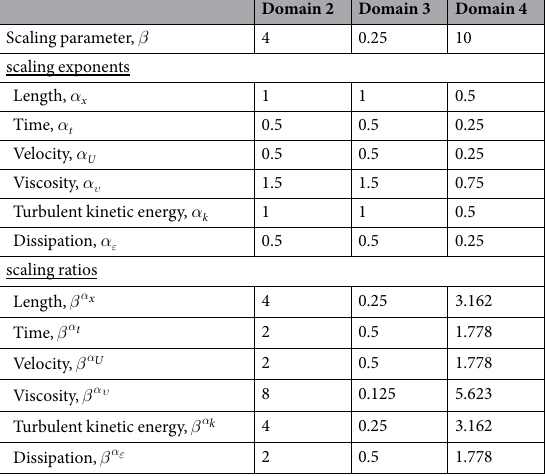
Table 3. Scaling exponents and ratios to obtain Domains 2, 3, and 4 from Domain 1.